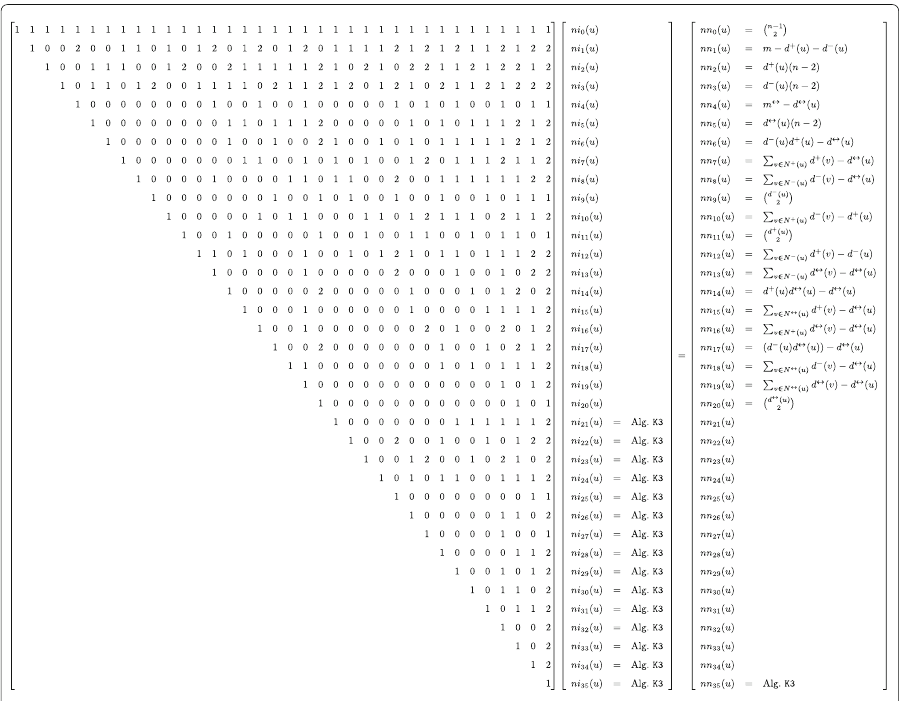
Fig. 8 System of equations for orbit-aware directed triad census on a node level. ni refers to induced and nn to non-induced